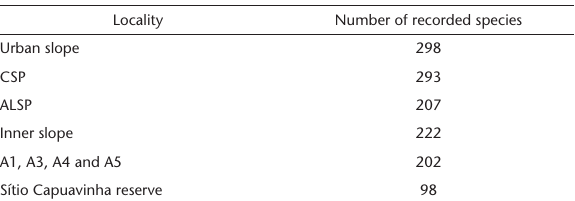
Table 1. Number of species recorded in the different slopes of Serra da Cantareira. Urban slope corresponds to species recorded in Can- tareira and Alberto Löfgren State Parks. Inner slope corresponds to species recorded in the slope faced to inner Atlantic forest in A1, A3, A4, A5 and the private reserve Sítio Capuavinha. In this table we did not take into account species which the location pointed only to Serra da Cantareira.